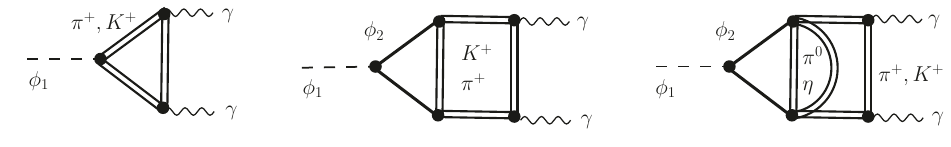
(cid:13)(cid:13) , matching onto the coupling g 1 (cid:13)(cid:13) . !